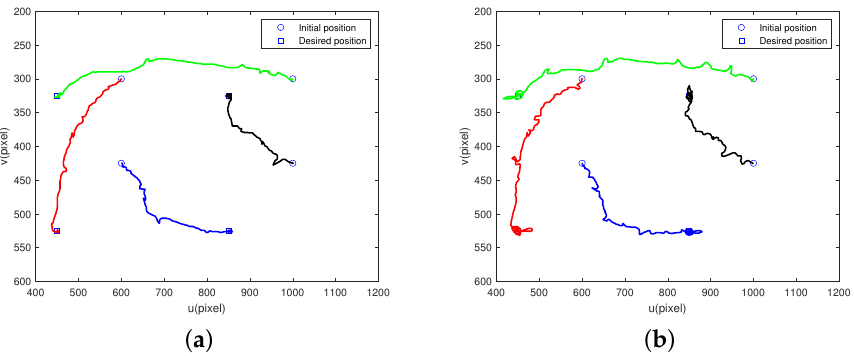
Figure 14. Trajectories of the image features of comparative simulations with time-varying external disturbances for the 6-DOF robot manipulator. ( a ) Trajectories of the image features in Case 3. ( b ) Trajectories of the image features in Case